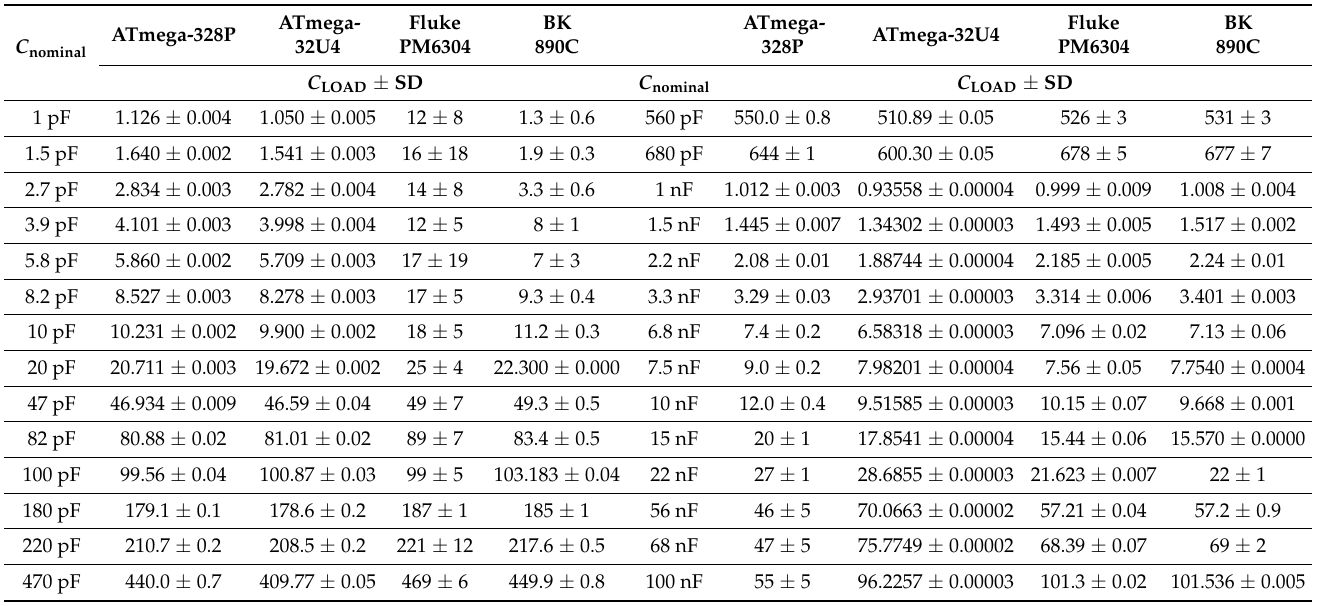
Table 4. Comparison of the ATmega328P, ATmega32U4 and Fluke 8840A measured load capacitance ( C LOAD ) values ± standard deviation (SD) through the fast acquisition